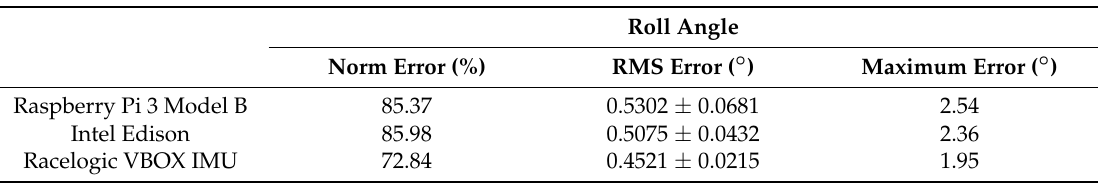
Table 5. Test 2. Errors of estimated roll angle on Raspberry Pi 3 Model B and Intel Edison compared with the measured roll from VBOX (ground truth).